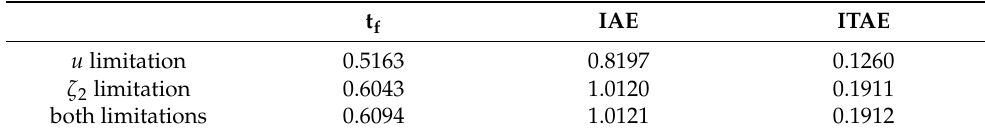
Figure 13. State trajectory with both input and velocity constraints. Table 1. Comparison of well-known quality